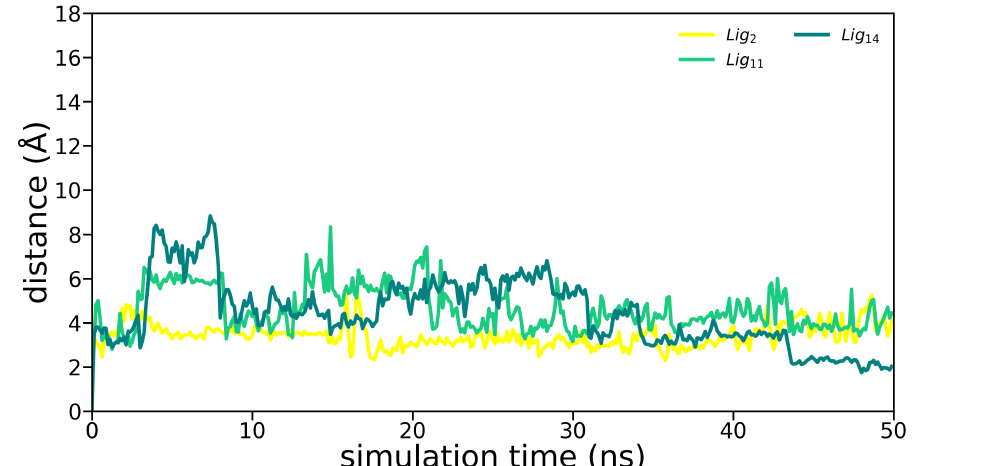
Figure A2. COM distance between the ligands staying closest to the binding site during the com- plex simulations.